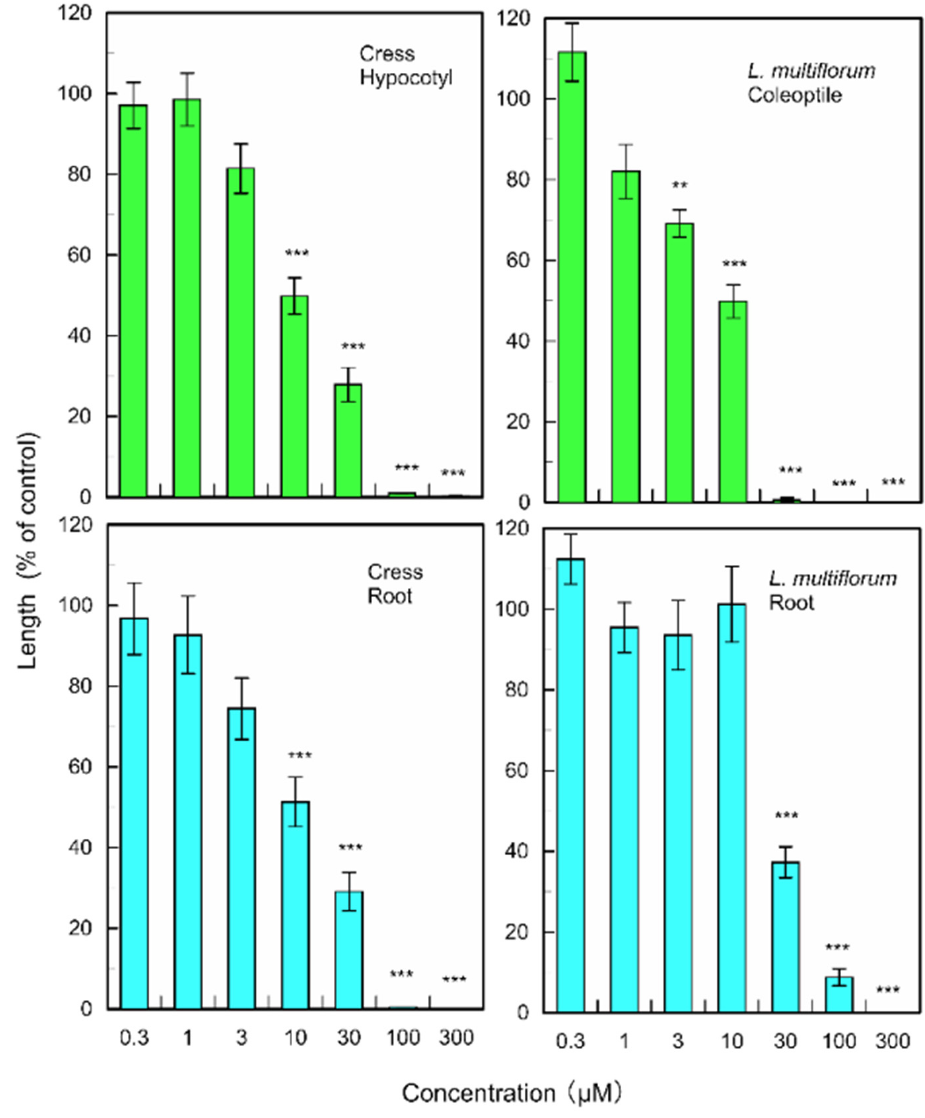
Figure 7. Effects of 9- epi -blumenol C on root and hypocotyl/coleoptile growth of cress and L. multiflorum. Means ± SE from 2 independent experiments with 10 seedlings for each determination are shown. Asterisks indicate significant differences between control and treatment: **, p < 0.01, ***, p < 0.001.